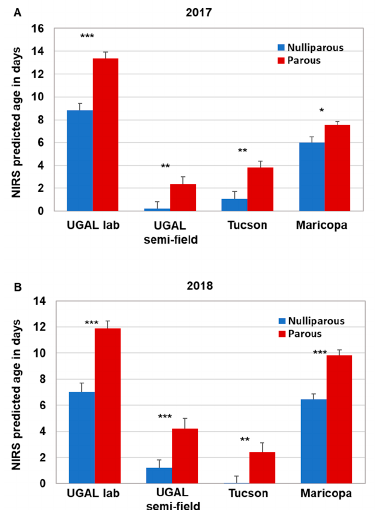
Figure 4. Parity status of field-collected mosquitoes relative to NIRS age predictions. Female Ae. aegypti from our field-collected samples in 2017 ( A ) and 2018 ( B ) were separated based on parity status. NIRS spectra for field-collected nulliparous and parous mosquitoes were acquired, and NIRS age predictions for the four models were determined. As expected, field-collected parous mosquitoes were scored significantly older than nulliparous mosquitoes by each of the NIRS models. Significance for each pairing was determined using the Kruskal–Wallis ANOVA followed by a Dunn’s post hoc test (significance is only shown between parous and nulliparous comparisons * = p < 0.05; ** = p < 0.01, *** p <